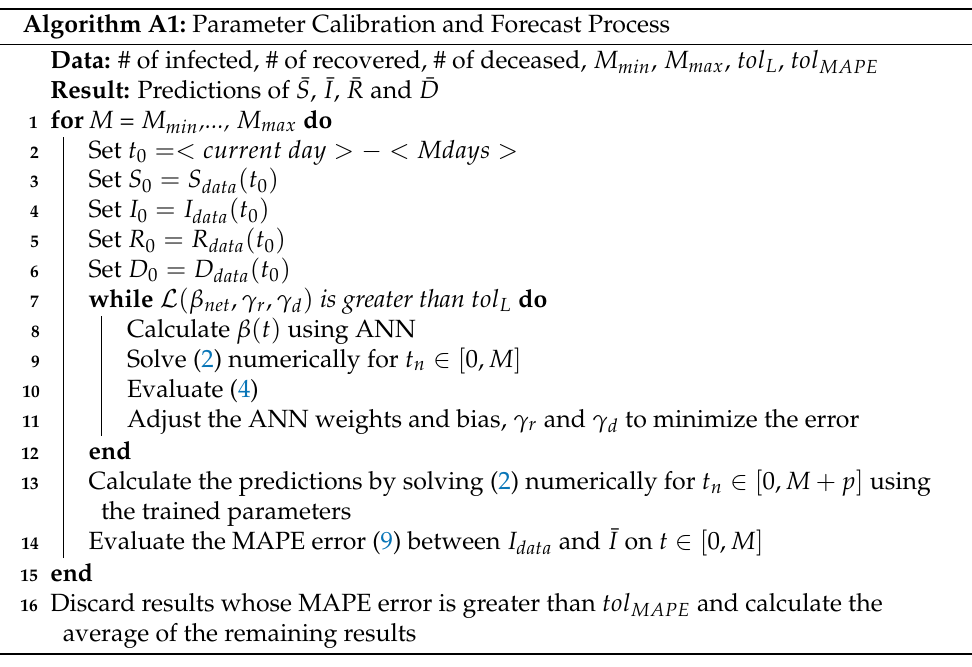
Algorithm A1: Parameter Calibration and Forecast